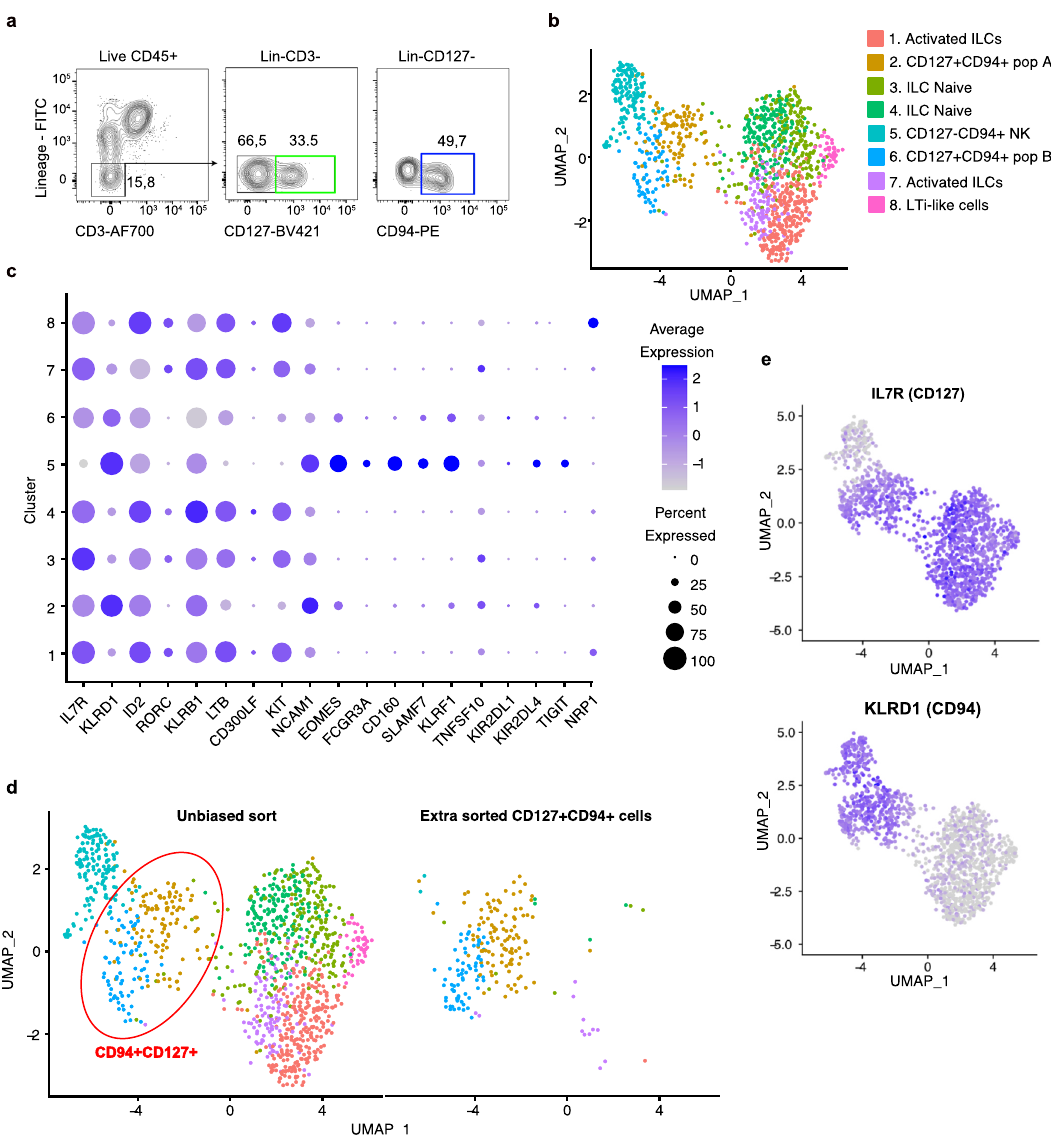
Fig. 1 Identi fi cation CD127 + CD94 + intestinal ILCs. a Gating strategy used for sorting of human intestinal ILCs. ILCs and NK cells were gated on viable CD45 + Lineage-(CD1a, CD3, CD4, CD5, CD14, CD19, CD34, CD123, CRTH2, BDCA2, TCR αβ , TCR γδ , and FcER1 α ) and subsequently on CD127 + for total ILCs and on CD127 − CD94 + for NK cells. b UMAP clustering of sorted ILCs and NK cells gated for as in ( a ). c Expression of indicated genes in clusters identi fi ed in ( b ). The color intensity indicates average expression level, and the size of the dot indicated the percentage of cells that express the gene. d UMAP clustering of extra sorted CD127 + CD94 + cells and clustering of total CD127 + population and CD127 − CD94 + population as in ( b ) e Expression of IL7R (CD127) and KLRD1 (CD94) plotted in purple on the UMAP clustering. Intensity of purple indicates the expression